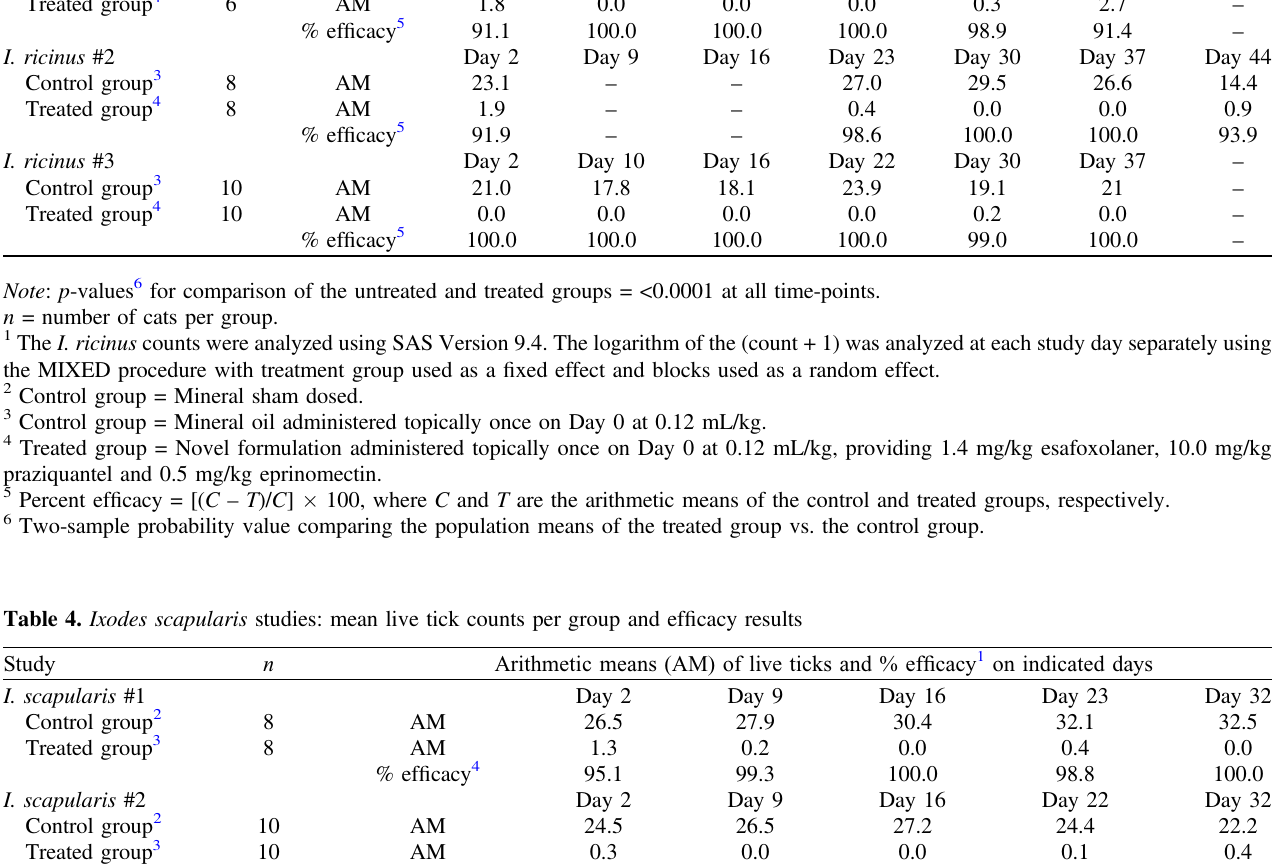
Table 3. Ixodes ricinus studies: mean live tick counts per group and ef fi cacy results. Study n Arithmetic means (AM) of live ticks and % efficacy 1 on indicated days